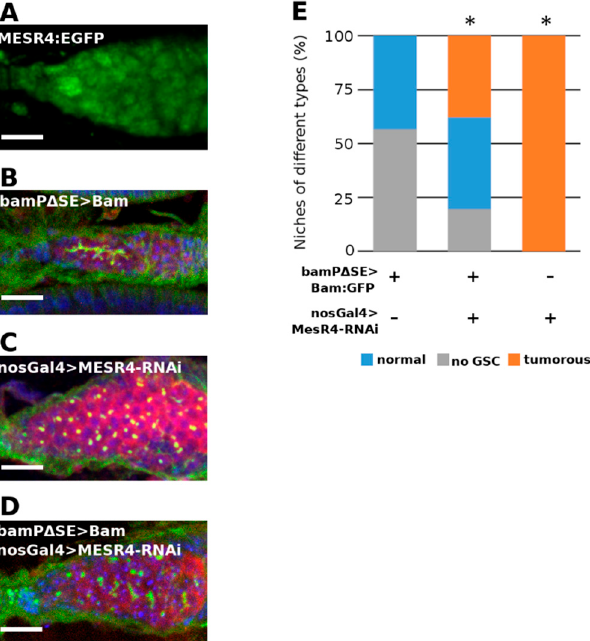
Figure 5. MESR4 silencing suppresses the GSC-loss phenotype caused by de-repressed bam expression . ( A ) Immunostaining showing localization of MESR4 :EGFP in the niche. MESR4 localizes in the nuclei of the somatic cells and in the nuclei of the germ cells. Scale bar: 10 µm. ( B – D ) Immunostaining of niches expressing transgenic bam under the control of the bam promoter lacking the pMad responsive SE silencing element. Niches were stained with DAPI (blue), vasa (red) and HTS (green). Scale bars: 10 µm. In bamP Δ SE-Bam:GFP niches ( B ) GSCs were lost; in nosGal4 > MESR4 -RNAi ( C ) niches GSC-like tumors were formed. In bamP Δ SE-Bam:GFP; nosGal4 > MESR4 -RNAi niches ( D ) the number of niches without GSCs were reduced. ( E ) Quantification of germ cell differentiation phenotypes of bamP Δ SE-Bam:GFP (n = 99), bamP Δ SE-Bam:GFP; nosGal4 > MESR4 - RNAi (n = 87), and nosGal4 > MESR4 -RNAi (n = 175) niches. Niches of the “no GSC” category lacked